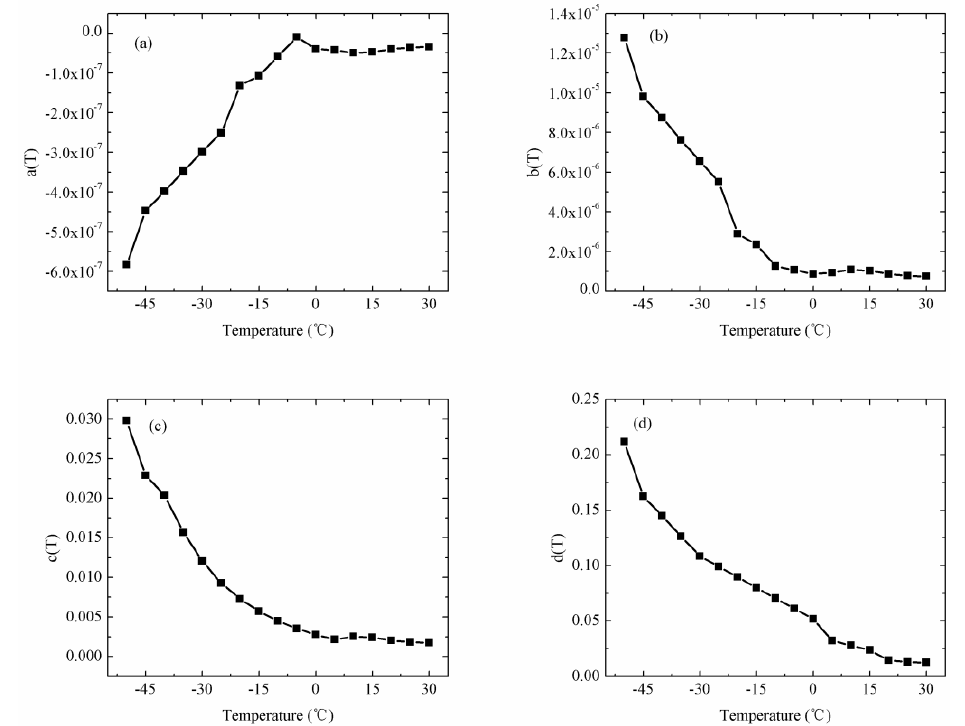
Figure 16. ( a – d ) Temperature dependence of coefficients a, b, c, and d, respectively.